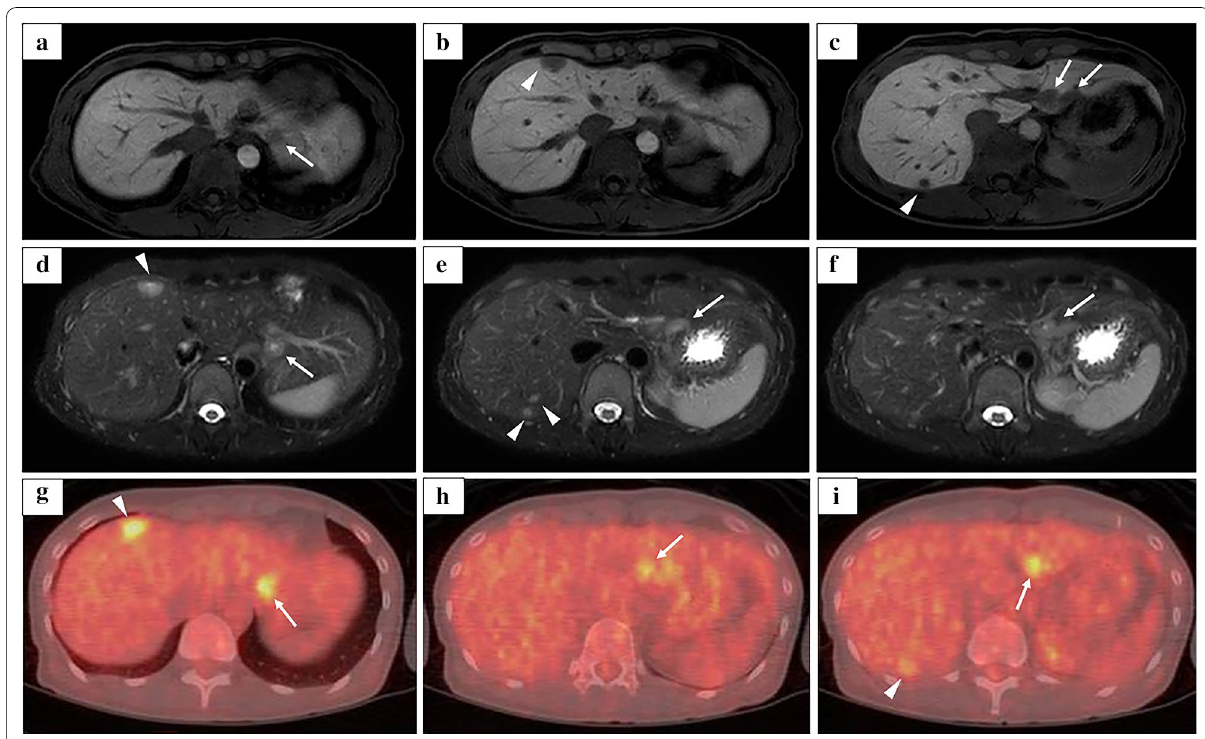
Fig. 2 a – c Gadolinium–ethoxybenzyl–diethylenetriamine–pentaacetic acid (Gd–EOB–DTPA) enhanced magnetic resonance imaging (MRI) revealed five tumors including a 15-mm tumor in the lateral superior segment (S2) ( a , arrow), a 20-mm tumor in the anterior superior segment (S8) ( b , arrowhead), a 16-mm ( c , arrow) tumor and a 20-mm tumor ( c , arrow) in the lateral inferior segment (S3), a 10-mm tumor in the posterior superior segment (S7) ( c , arrowhead). d – f T2-weighted MRI revealed six tumors including a 15-mm tumor in S2 ( d , arrow), a 16-mm ( e , arrow) tumor and